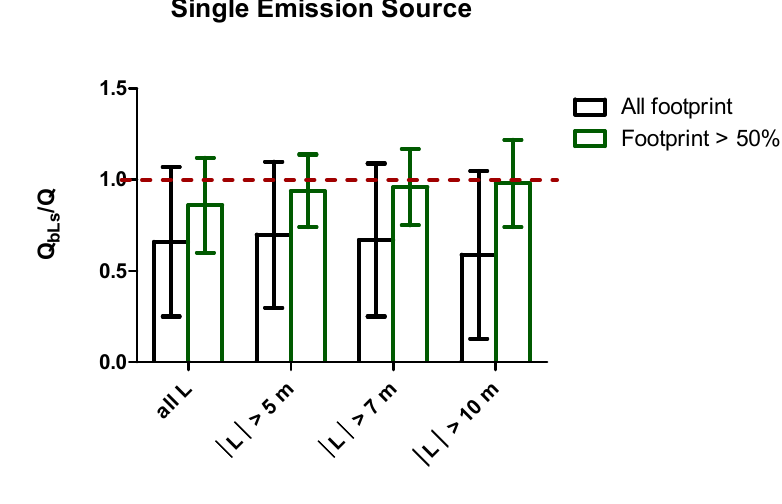
Figure 4. Accuracy of measured emission Q Obukhove length |L| and